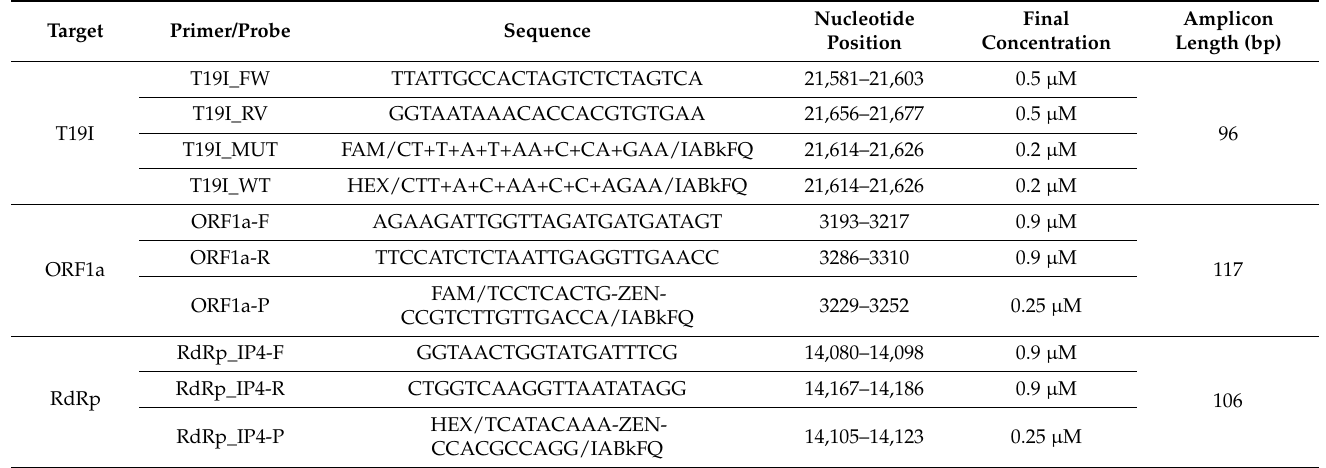
Table 1. Primers and probes that target the T19I variant and the general assays targeting the RdRp [24] and ORF1a [25] genes. A second, internal ZEN-quencher was added to ORF1a and RdRp probes to obtain greater overall dye quenching in addition to the Iowa Black FQ (IABkFQ) quencher. The indicated positions refer to the reference sequence NC_045512. The “+” within the sequences indicates the LNA nucleotides within the LNA